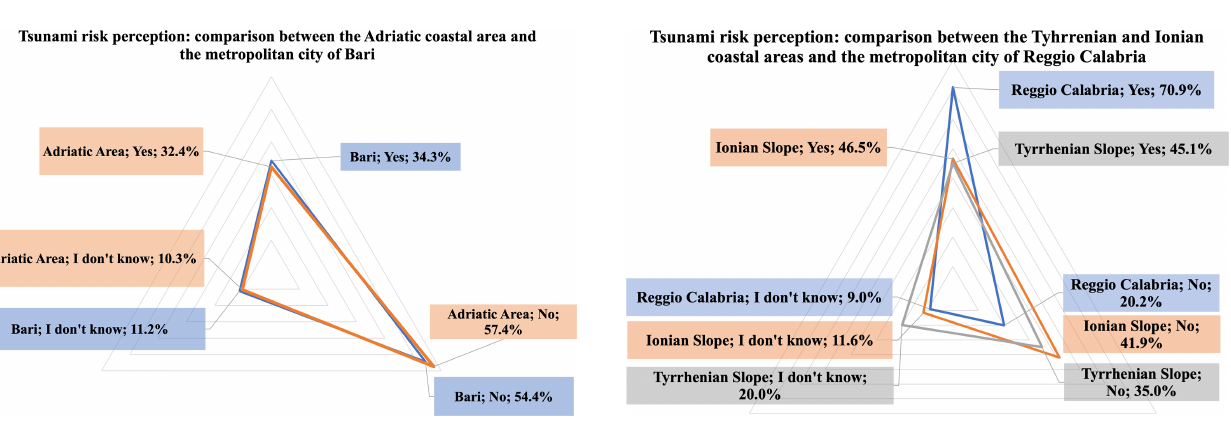
Figure 9. Tsunami risk perception (Q16): comparison between the Adriatic coastal area and the metropolitan city of Bari.